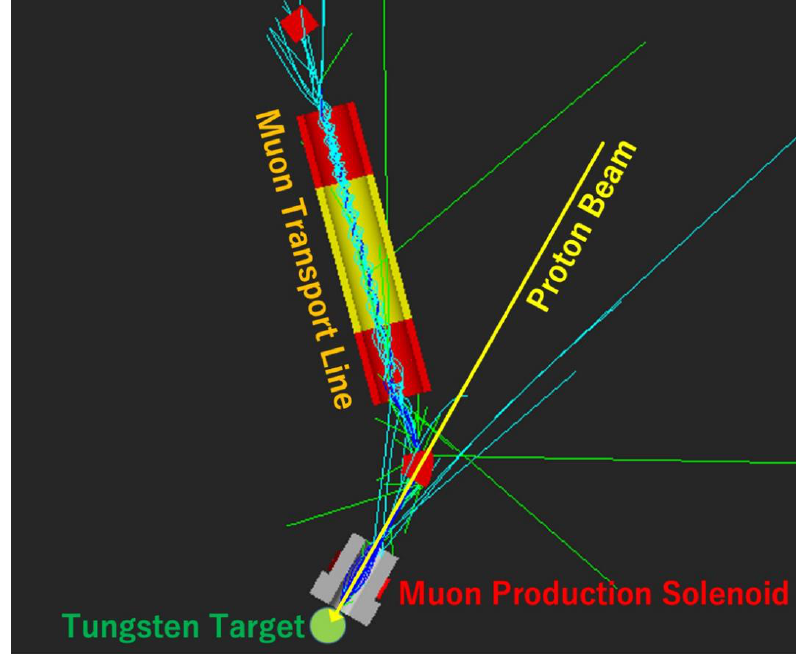
Figure 6. Proposed muon beam line for J-PARC MLF second target station TS2.